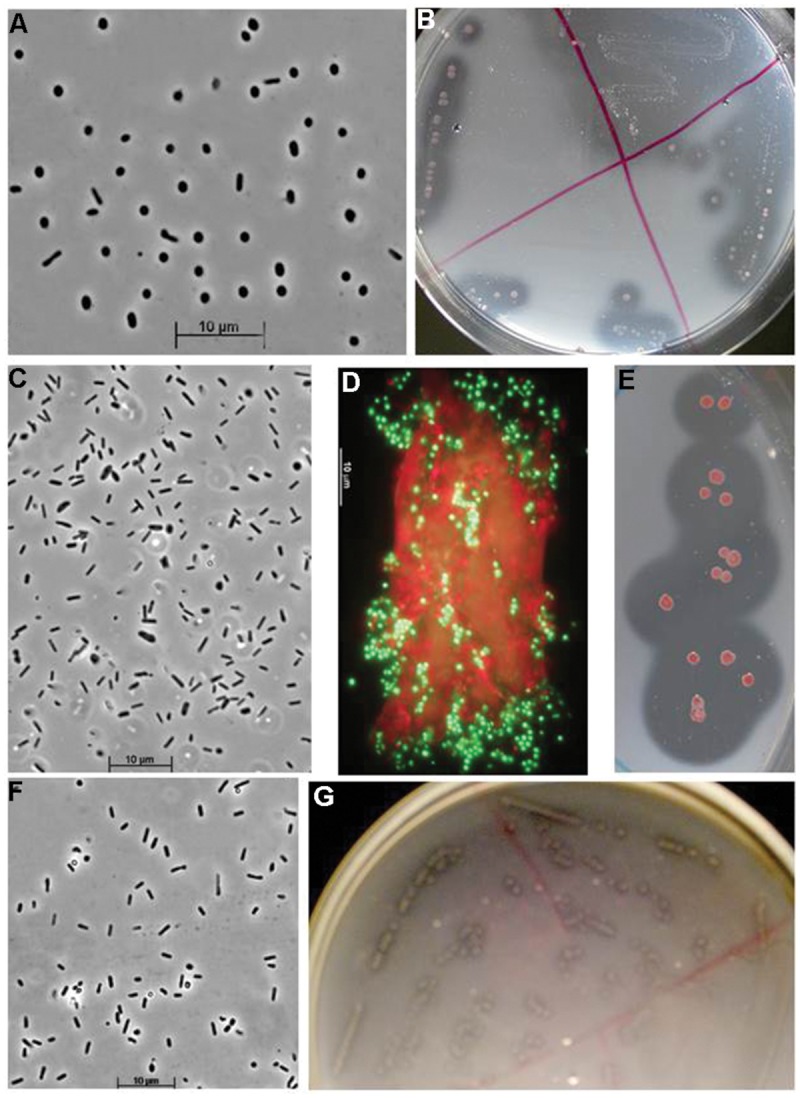
Cell and colony morphology of cellulotrophic natronoarchaea grown on amorphous cellulose at 4 M Na+, pH 9.5. (A,B) Strain AArcel1, (C) strain AArcel2, (D,E) strain AArcel9, and (F,G), strain AArcel7. (D) Adhesion of AArcel9 cells (green) to cellulose fibrilles (red) visualized by epifluorescent microscopy using SYTO-9 staining.